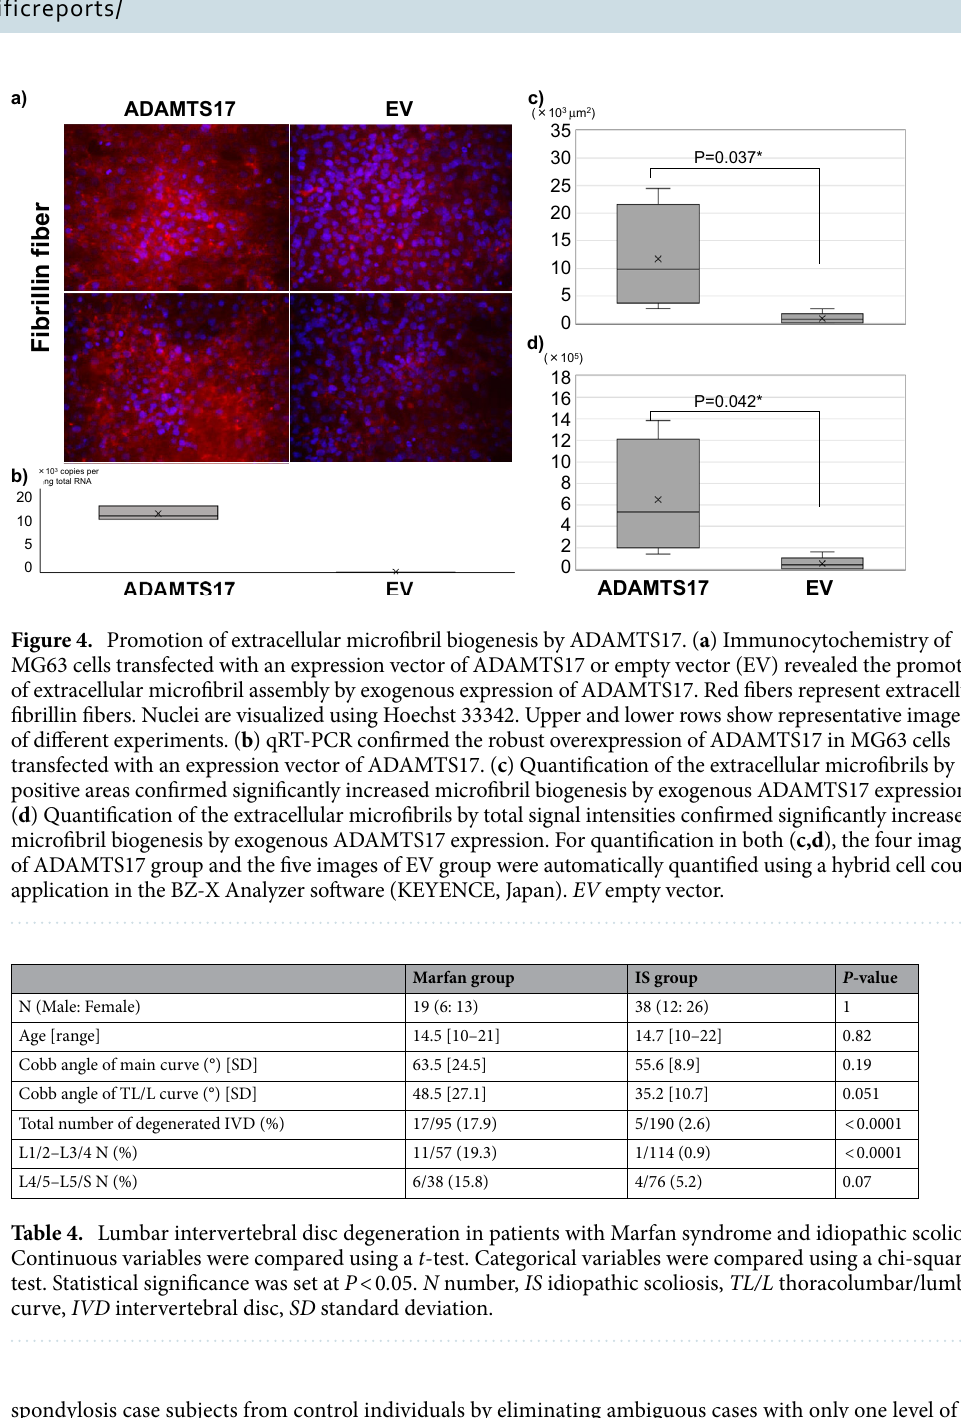
Table 4. Lumbar intervertebral disc degeneration in patients with Marfan syndrome and idiopathic scoliosis. Continuous variables were compared using a t -test. Categorical variables were compared using a chi-square test. Statistical significance was set at P < 0 . 05. N number, IS idiopathic scoliosis, TL/L thoracolumbar/lumbar curve, IVD intervertebral disc, SD standard deviation.